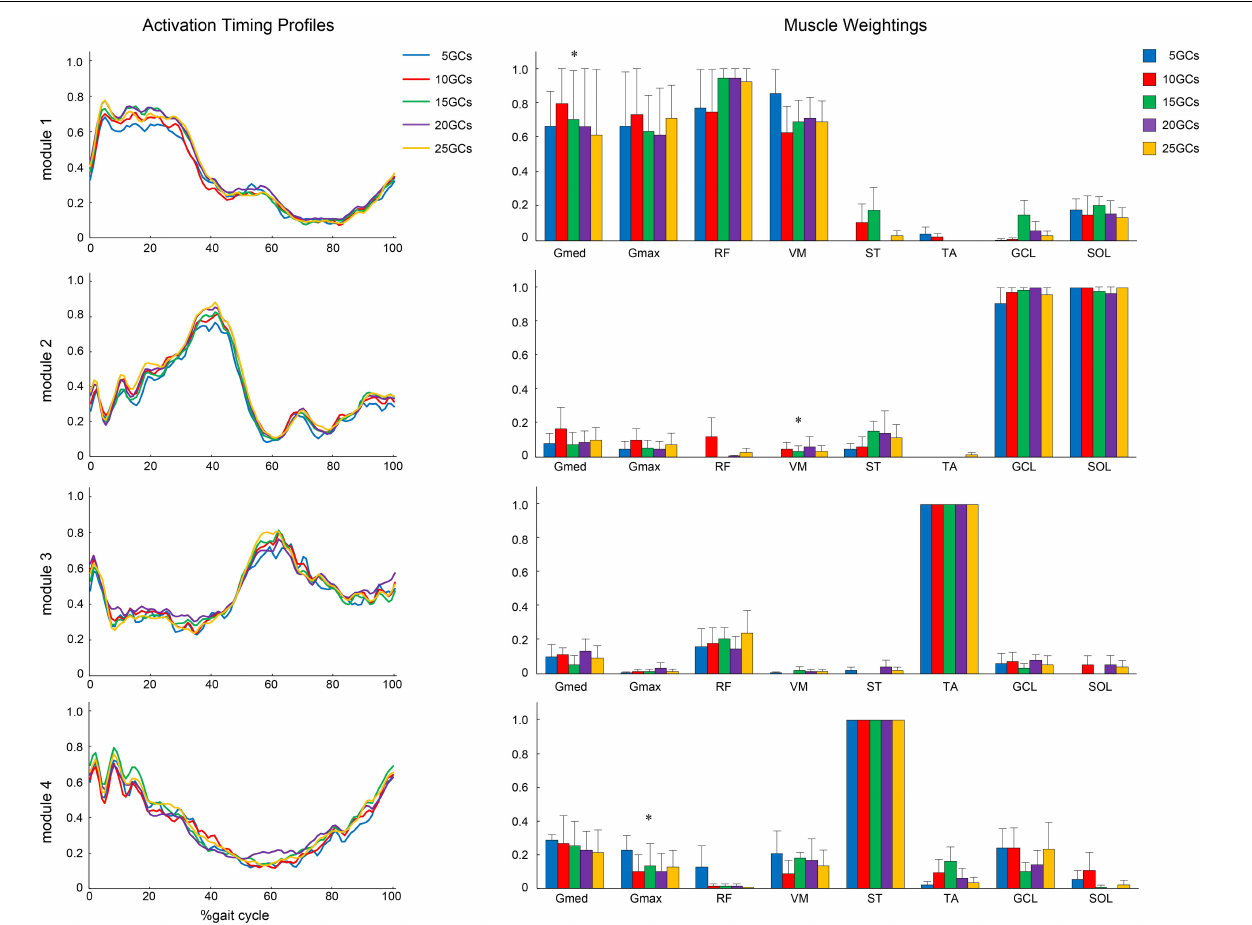
FIGURE 6 | The activation timing profiles and muscle weightings of assuming four modules. The effects of different GCs when the LPF was 15 Hz. Activation timing profiles are shown as the conditional mean. The bars of muscle weightings indicate the conditional median, and the error bars indicate the median absolute deviations. Significant differences are marked with ∗ ( p < 0.05 at the Friedman test only). LPF, low-pass